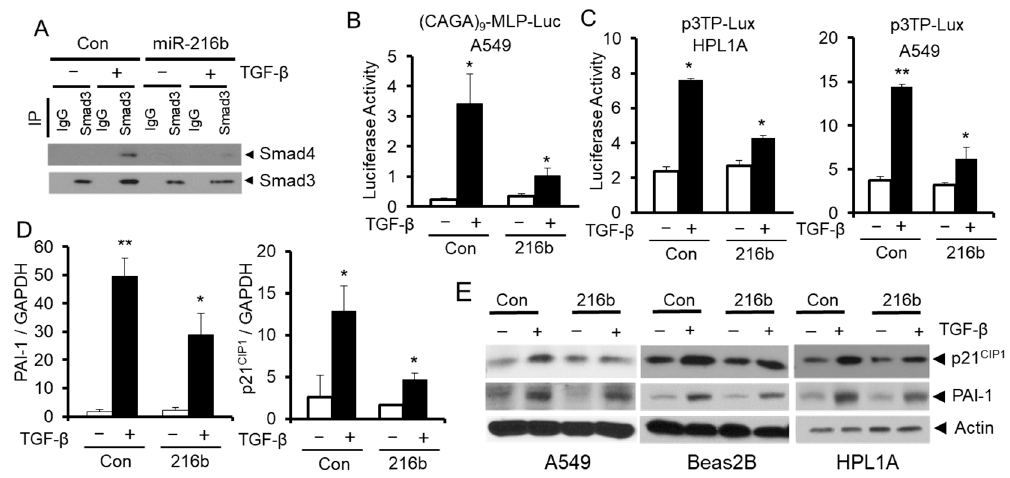
Figure 5. MiR-216b attenuates TGF- β / Smad signaling. ( A ) HPL1A cells were transfected by miR-216b mimic or control miRNA mimic. Forty-eight hours after transfection, cells were harvested for protein extraction. The lysates were incubated with anti-Smad3 antibody or rabbit IgG and protein-A agarose beads. The precipitated protein complexes were analyzed by Western blotting with anti-Smad4 and anti-Smad3 antibodies. ( B , C ) HPL1A and A549 cells were co-transfected with TGF- β signaling reporter vector containing TGF- β response element, (CAGA) 9 MLP-Luc ( B ) or the p3TP-Lux reporter ( C ) and miR-216b mimic or control miRNA mimic. Twenty-four hours after transfection, cells were treated with 5 ng / mL TGF- β 1 for 22 h. Luciferase activity was normalized to internal control β -Gal activity ( n = 3, mean activity levels and SD are displayed), p < 0.05. ( D ) HPL1A cells were transfected with miR-216b mimic or control miRNA mimic. Twenty-four hours after transfection, cells were exposed to 2 ng / mL TGF-ß for 6 h and then harvested for RNA purification. p21 CIP1 and PAI-1 mRNA levels were analyzed by qRT-PCR. ( E ) A549, Beas2B and HPL1A cells were transfected with miR-216b mimic or control miRNA mimic. Forty-eight hours after transfection, cells were exposed to 2 ng / mL TGF- β for 6 h and then harvested for Western blotting with anti-p21 CIP1 and anti-PAI-1 antibodies.